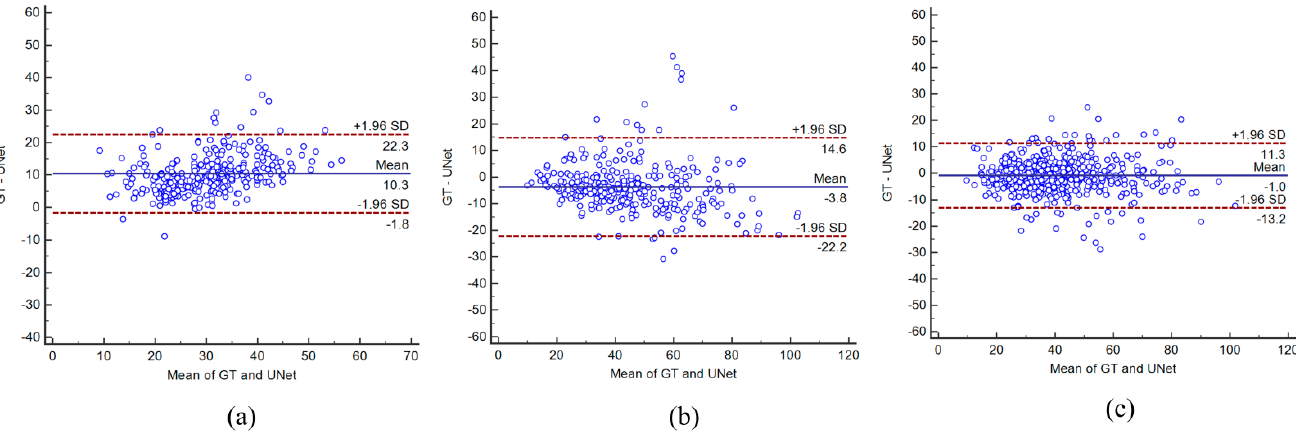
Figure 8. Bland-Altman’s plots for Unseen and Seen experiments. ( a ) Experiment #1 (Unseen AI-1 (Tr: JAP, Te: HK)) ( b ) experiment #2 (Unseen AI-2 (Tr: HK, Te: JAP)) ( c ) experiment #3 (Seen AI-1 CV w/ Mixed).